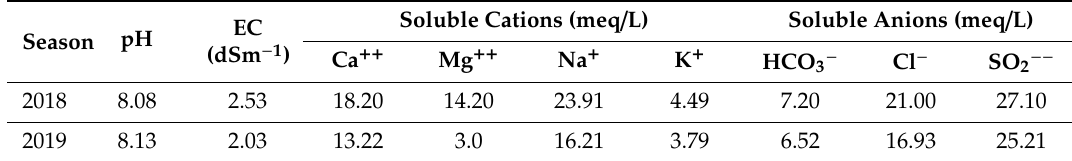
Table 9. Some chemical analyses of the used mixture soil for two successive seasons, 2018 and 2019. Season